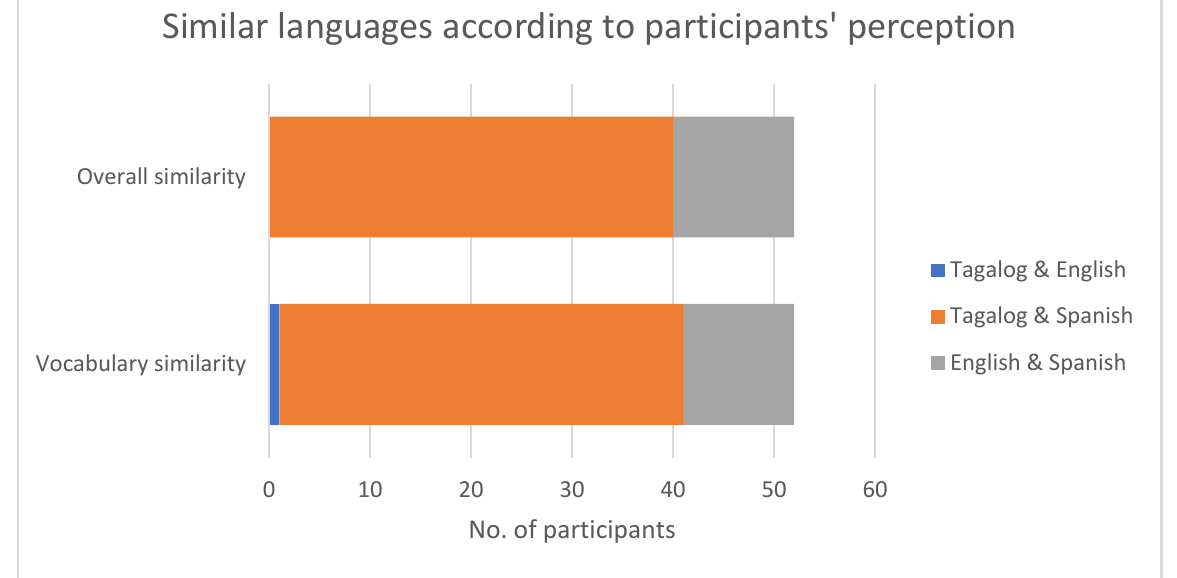
Figure 1. Perceptions of general and vocabulary similarity between languages.